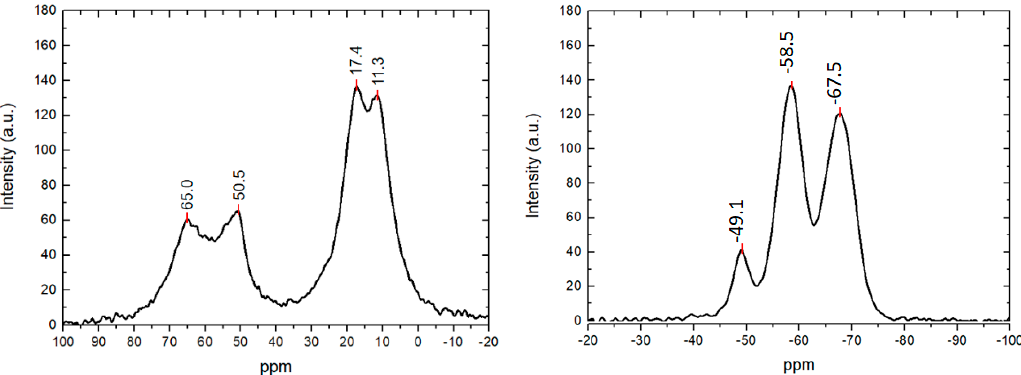
Figure 1. 1 H-NMR kinetic study of the hydrolysis of compound 4 in D 2 O.